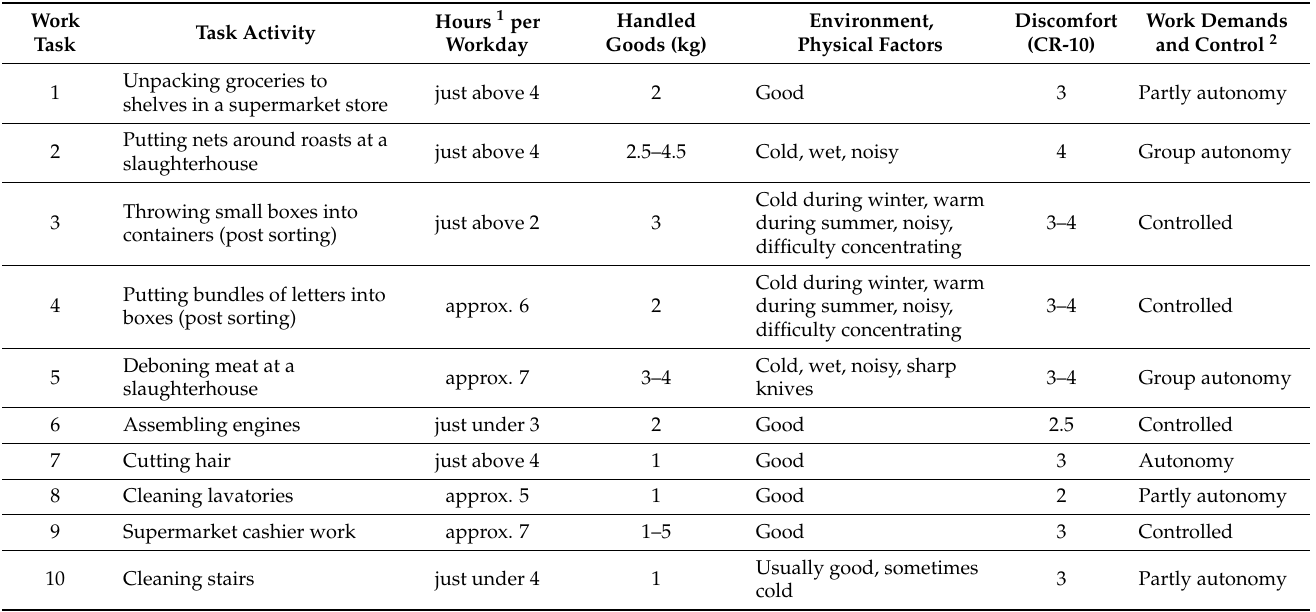
Table 1. Descriptions of the ten different video-recorded work tasks in the